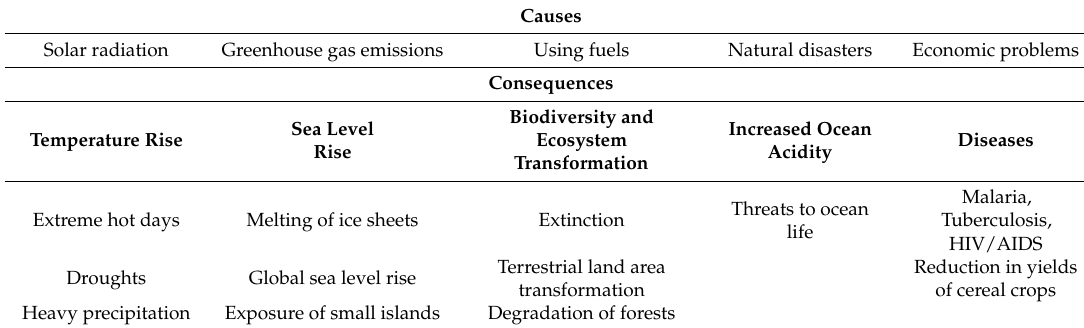
Table 1. Causes and consequences of global warming